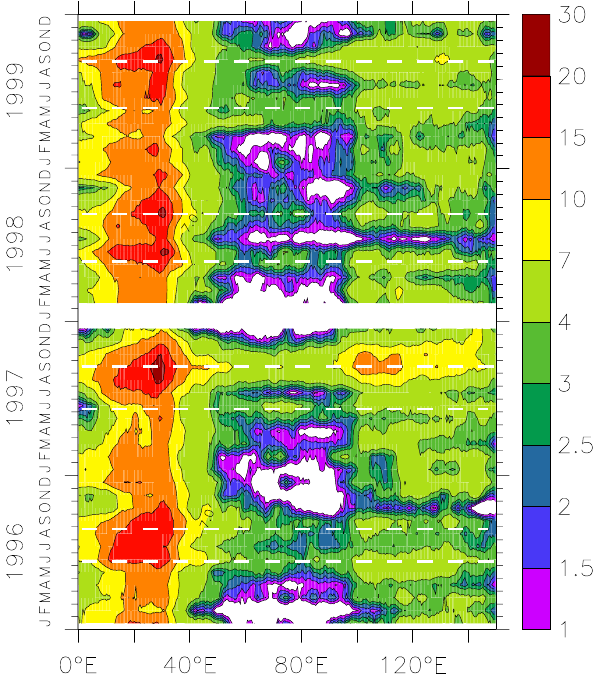
Fig. 51. Tropospheric NO 2 column (in 10 14 molecules/cm 2 ) aver- Figure 1. Tropospheric NO column (in 10 14 molecules/cm 2 ) averaged for 5 (cid:1) N–30 (cid:1) S from (a) GOME (b) MATCH; only 2 aged for 5 ◦ N–30 ◦ S during 1996–1999 from the GOME satellite the overlapping period (1996 –1999) is plotted; results are similar for the full data sets of each; see Figure 2 for a map of the instrument (from Kunhikrishnan et al., 2004, copyright 2004 by the region. American Geophysical Union, reproduced with permission).